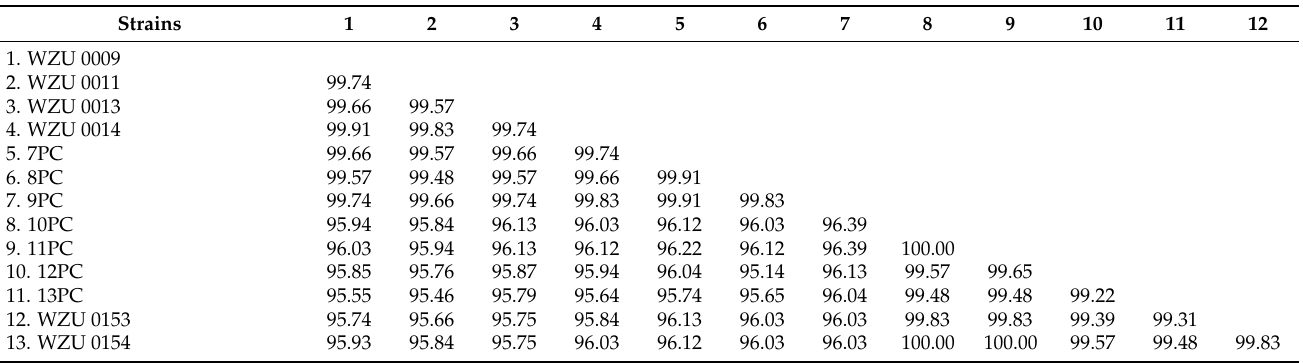
Table 4. Comparison of the 16S rRNA gene sequence similarity among all Ancylothrix strains. Strains